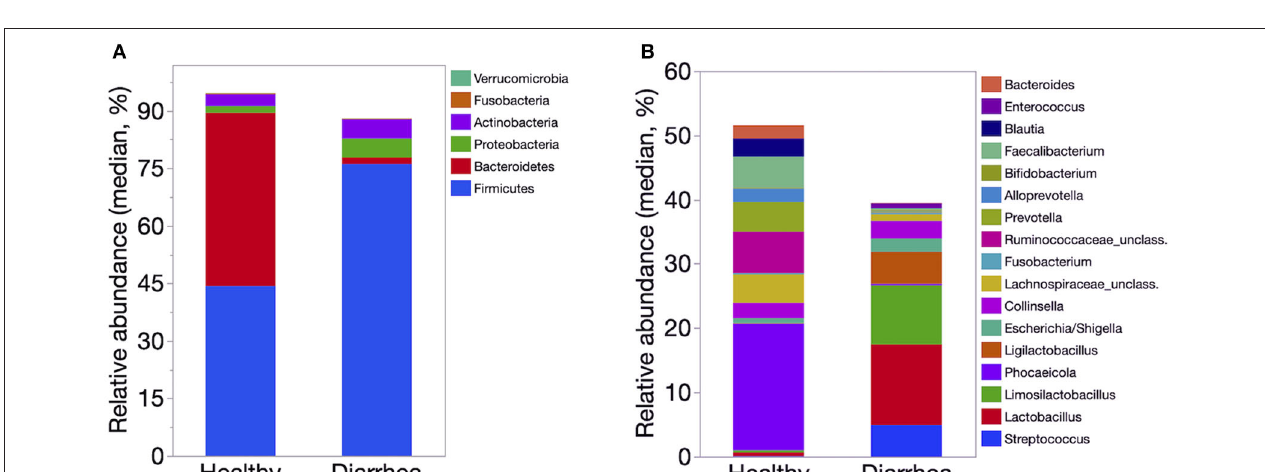
FIGURE 3 | Principal coordinate analysis (PCoA) of bacterial community (A) membership (Classic Jaccard analysis) and (B) structure (Yue and Clayton analysis). Samples from these 20 healthy (green circles) and 31 calves with diarrhea were analyzed. Comparison between healthy and diarrheic calves showed significant difference in community membership and structure (AMOVA P < 0.001, for both comparisons).